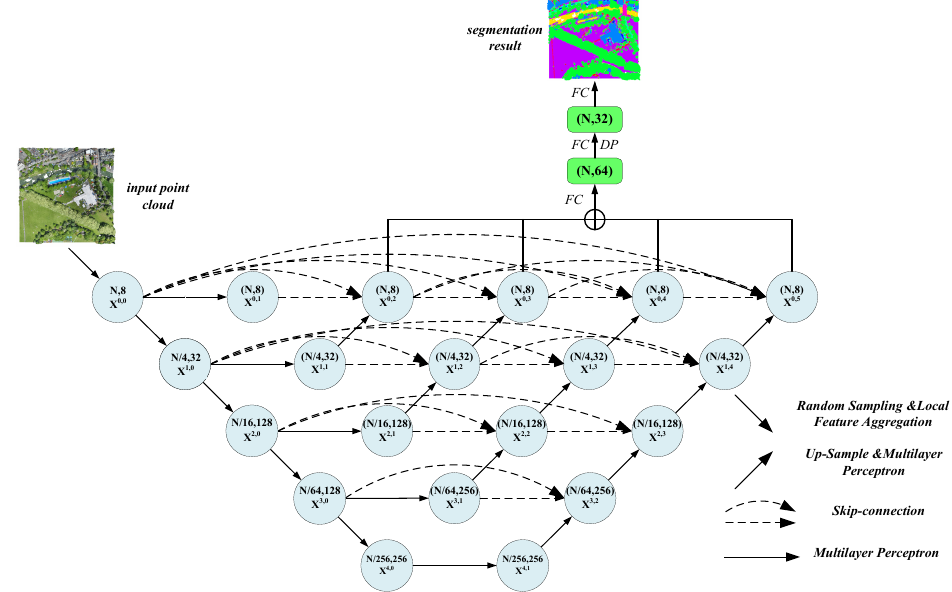
Figure 5. The structure of RandLA-Net++. The numbers in the circles show the number of channels of the feature and the number of input points, respectively.